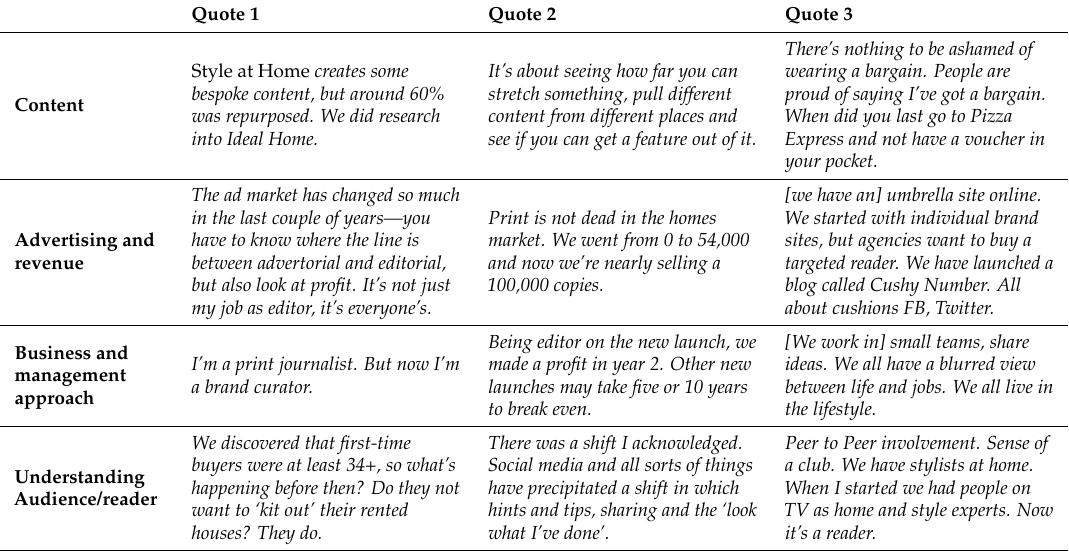
Table 2. Case Study: Style at